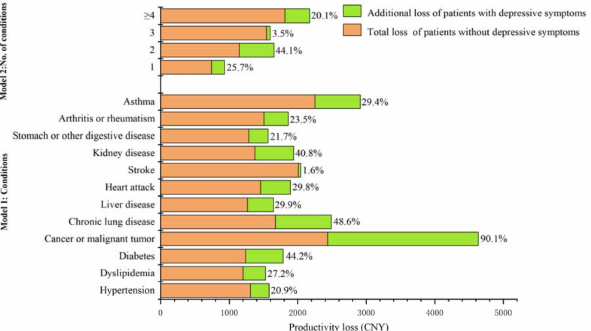
Figure 2. Comparing the proportion of additional productivity loss to the total loss of patients without depressive symptoms. Note: The data details used in drawing Figure 2 are shown in Table